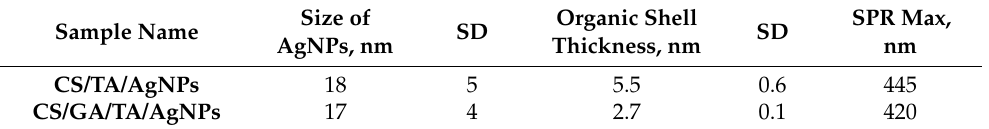
Table 2. Size of the AgNPs and thin organic shells around the core for different polymer blend